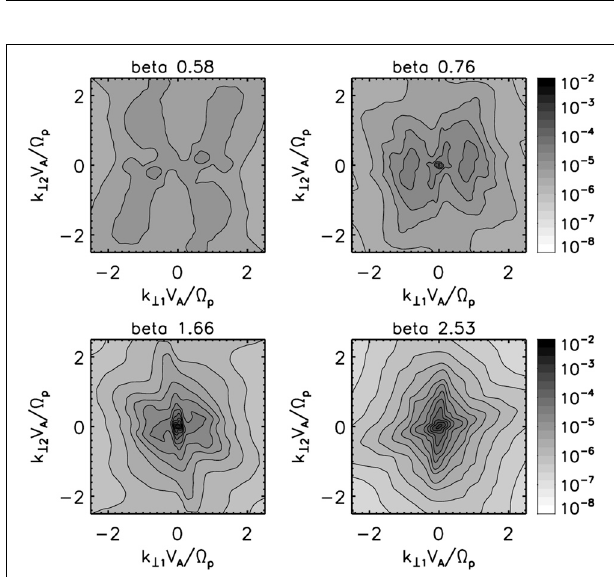
FIGURE 5 | Energy spectra of magnetic field fluctuations in the wave vector domain perpendicular to the large-scale magnetic field. Data are taken from Cluster measurements in the solar